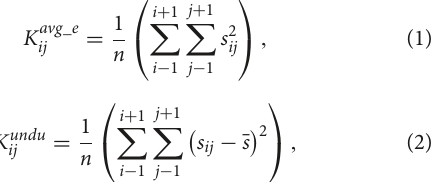
camera are calibrated in typical scenarios. First, the range and azimuth measurement results of the radar sensor are calibrated based on angle reflectors. Then, some cooperative pedestrians, cyclists, and cars are employed as detection objects on a test road. The radar data and optical images are recorded separately, and the locations and other information of the objects from the two sensors are compared and calibrated. Finally, after collecting the measured data, the RoIs in RD maps are labeled based on the optical